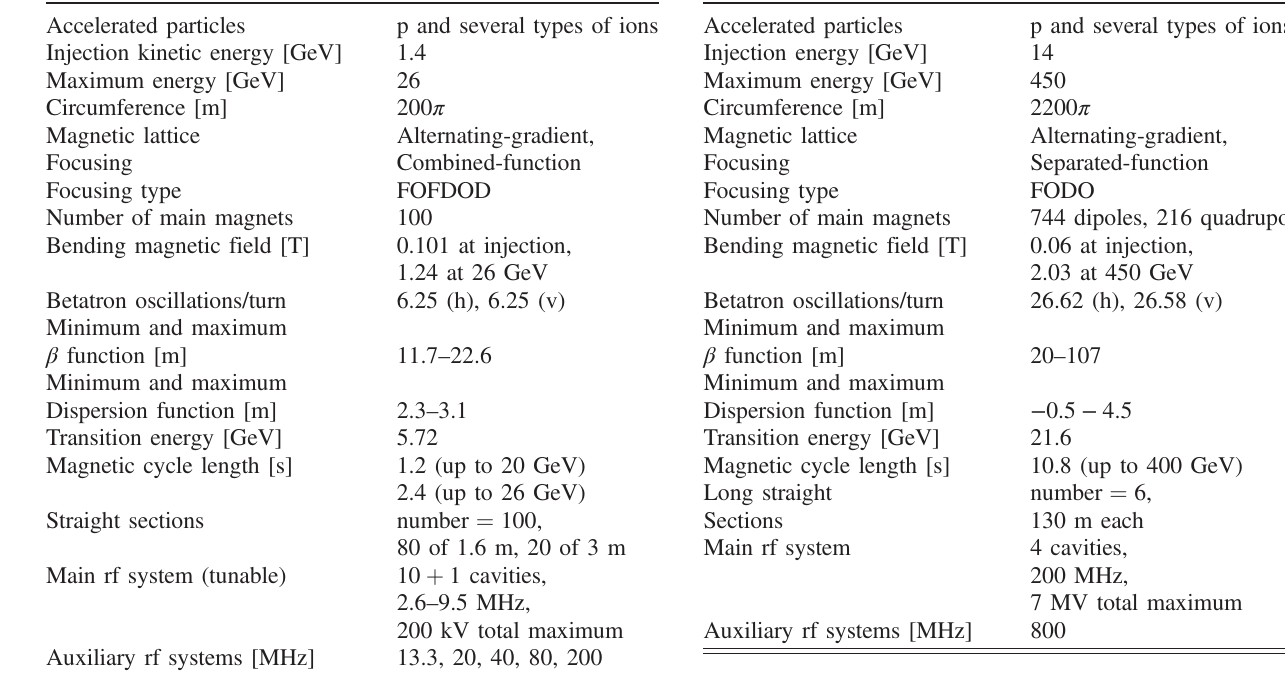
TABLE IV. Basic parameters of the SPS ring. The cycle length refers to the time needed from injection up to extraction energy (including the time for single-turn or slow beam extraction) and back again to injection. The cycle length is a multiple of the PSB repetition rate, which is 1.2